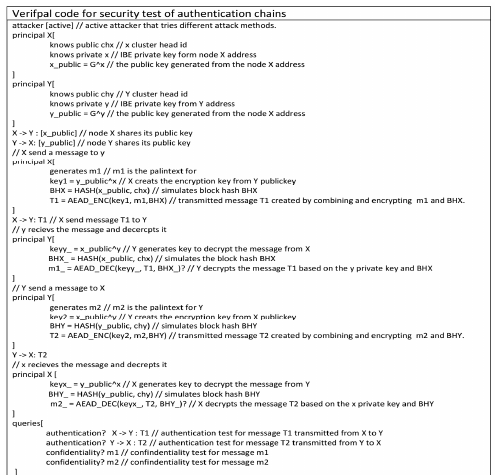
Figure 9. Verifpal security analysis